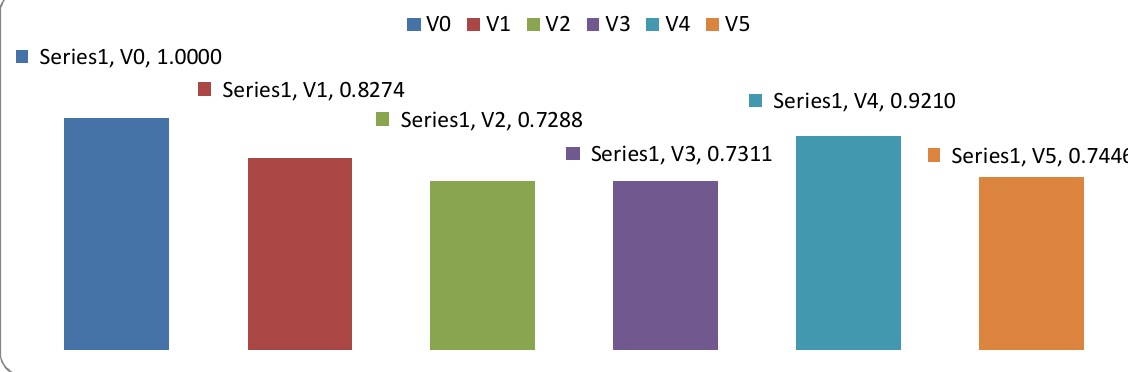
Fig. 2. The distribution of degree of the alternative